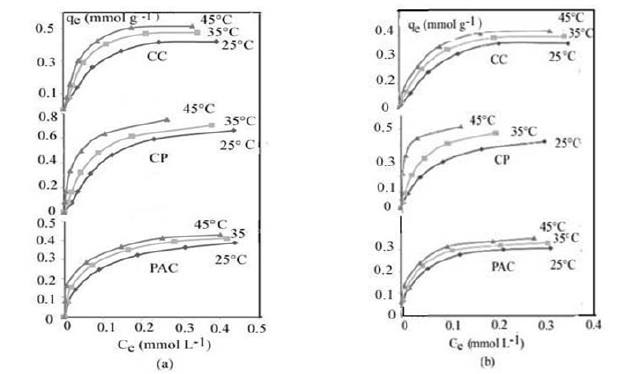
Figure 3. The adsorption curves of (a) AR 183 and (b) AR114 dyes onto adsorbents. As expected for the effect of adsorbent dose, the equilibrium uptakes of dye present optimum values for 0.1g of adsorbents 4,26 . Besides, the efficiency increases with temperature indicating endothermic incorporations of dyes into adsorbents, which could be considered as chemical adsorption 27 .